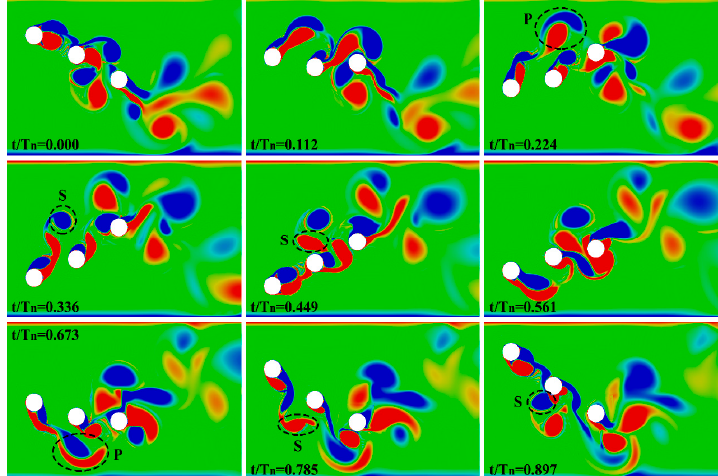
Figure 12. Near-wake structure of the three cylinders when Re = 90,000. Energies 2018 , 11 , x FOR PEER REVIEW